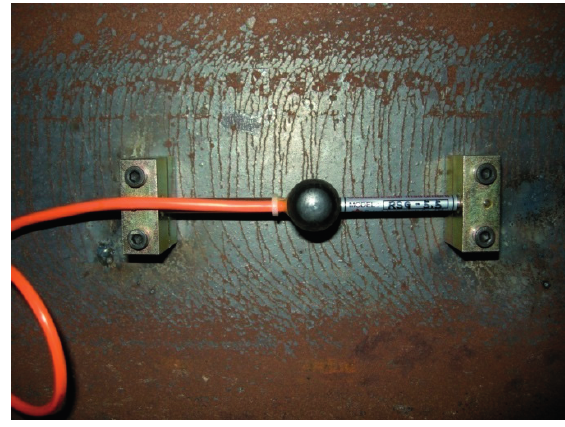
Figure 3. n -Span continuous beam supported by n + 1 ground anchors.